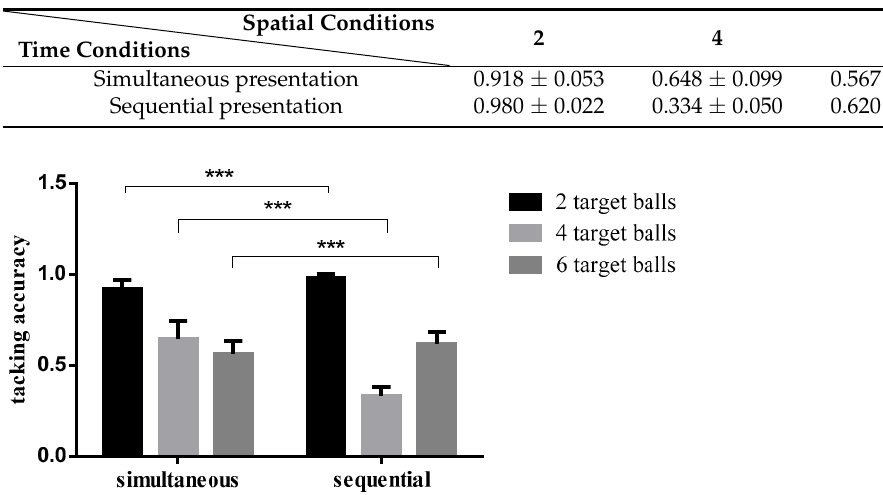
Table 3. Tracking accuracy (M ± SD, N = 33).